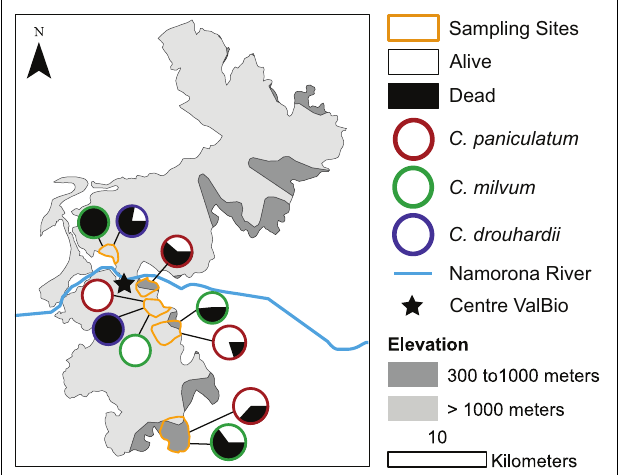
FIGURE 3 | Map of surveys of Calophyllum spp . within five sites in Ranomafana National Park, Madagascar with elevation and proportion of dead and living trees by